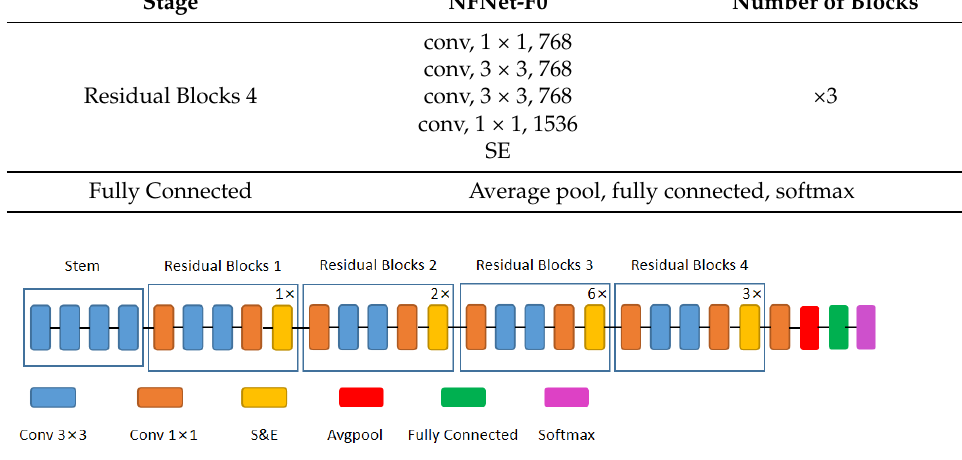
Figure 4. Schematic diagram of the NFNet-F0 model (compressed view).